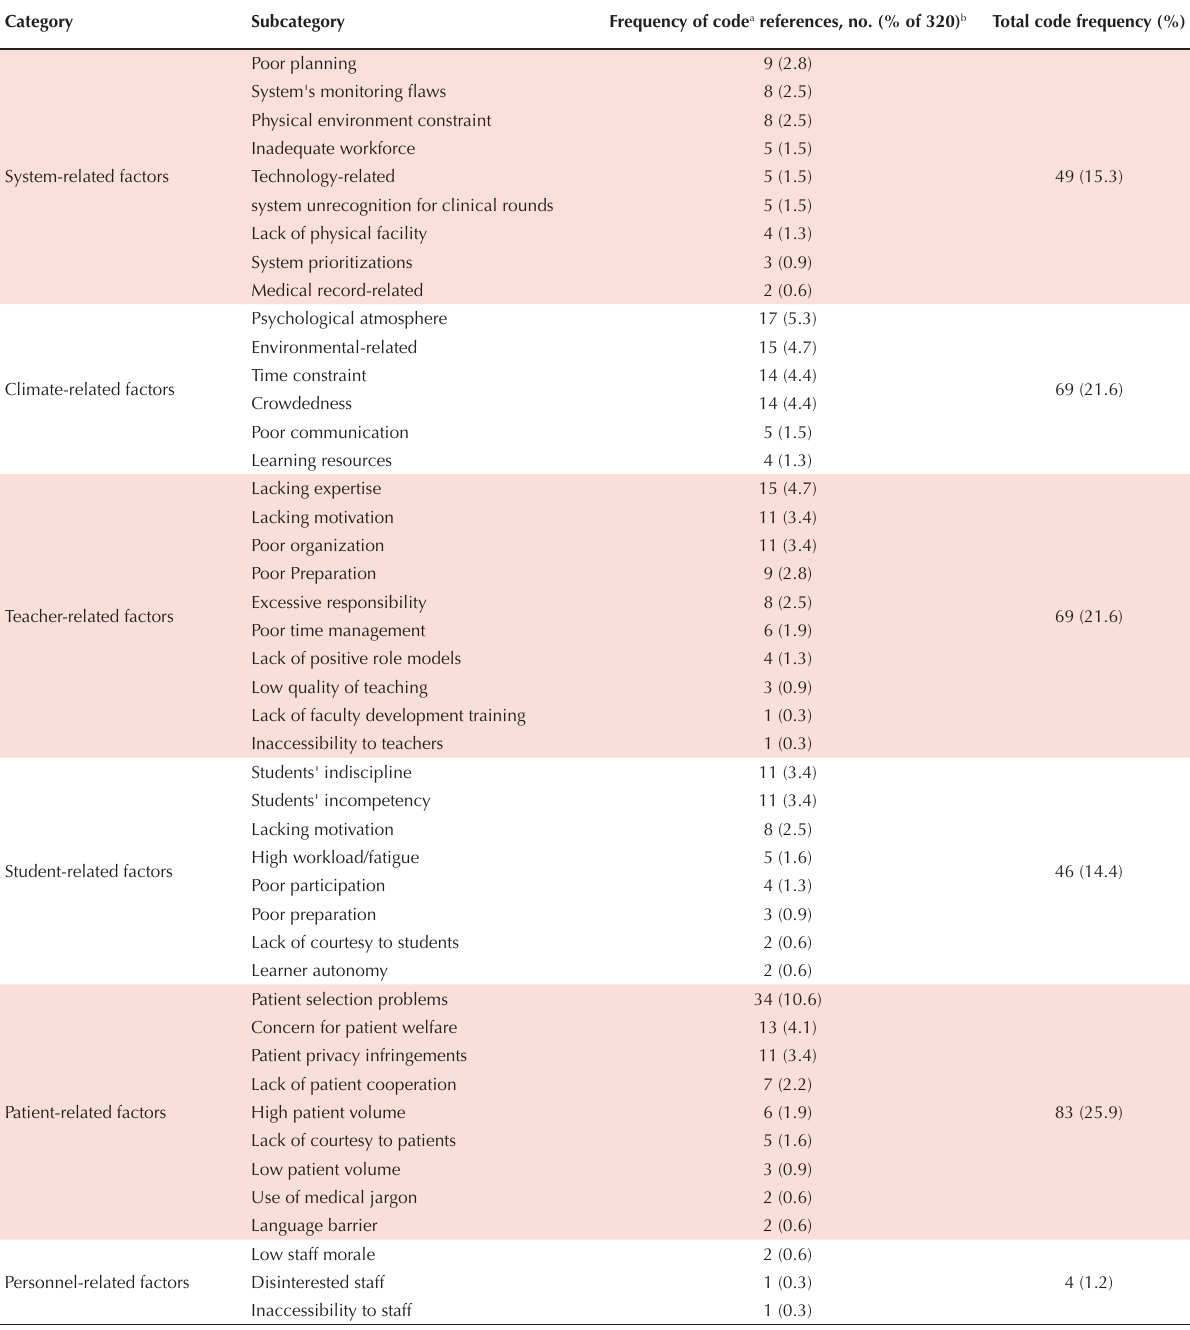
Table 3. Barriers to clinical rounds identified in the English-language literature (320 total coding references) Category Subcategory Frequency of code a references, no. (% of 320)